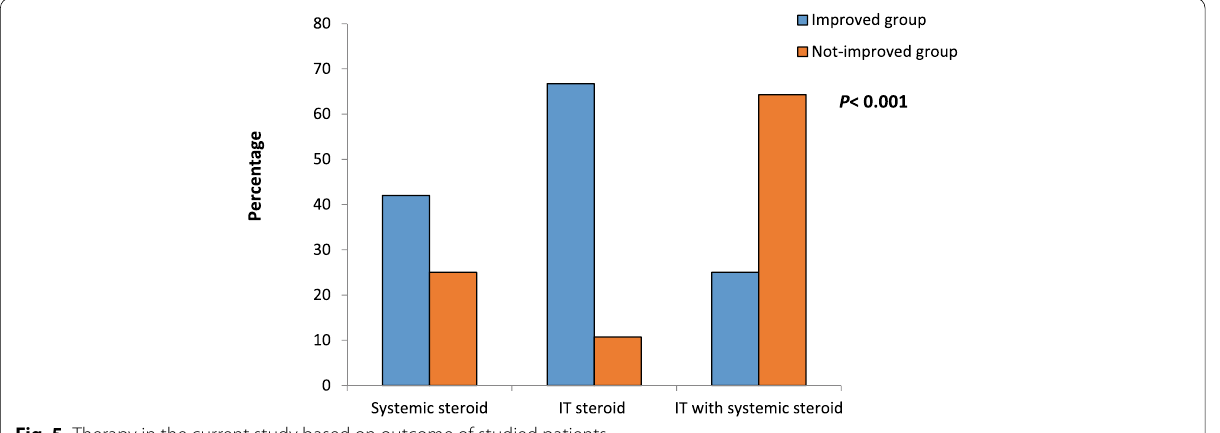
Fig. 5 Therapy in the current study based on outcome of studied